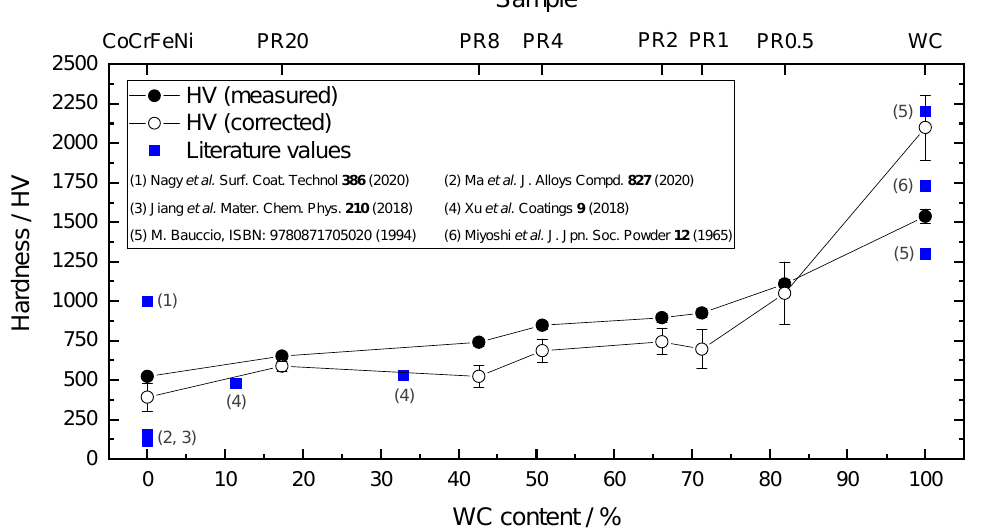
Figure 4. Hardness values of the sputtered thin films as obtained from nanoindentation (black filled circles) and after thin film correction according to [20] (empty circles) as a function of the WC content determined by XPS. Literature values from [6,12,13,16,17,27] are presented for comparison (blue squares). The error bars correspond to the maximum error